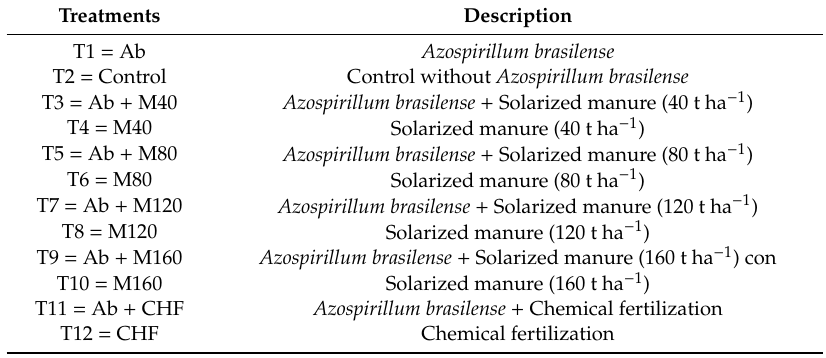
Table 1. Treatments established with Azospirillum brasilense (Ab) as a plant growth-promoting bacterium (PGPB) and doses of solarized manure on tomato plants under shadow house